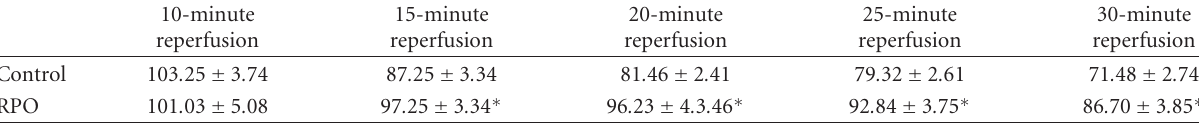
Table 2: Post-ischaemic % LVDevP recoveries for controls and RPO hearts at di ff erent reperfusion time points.